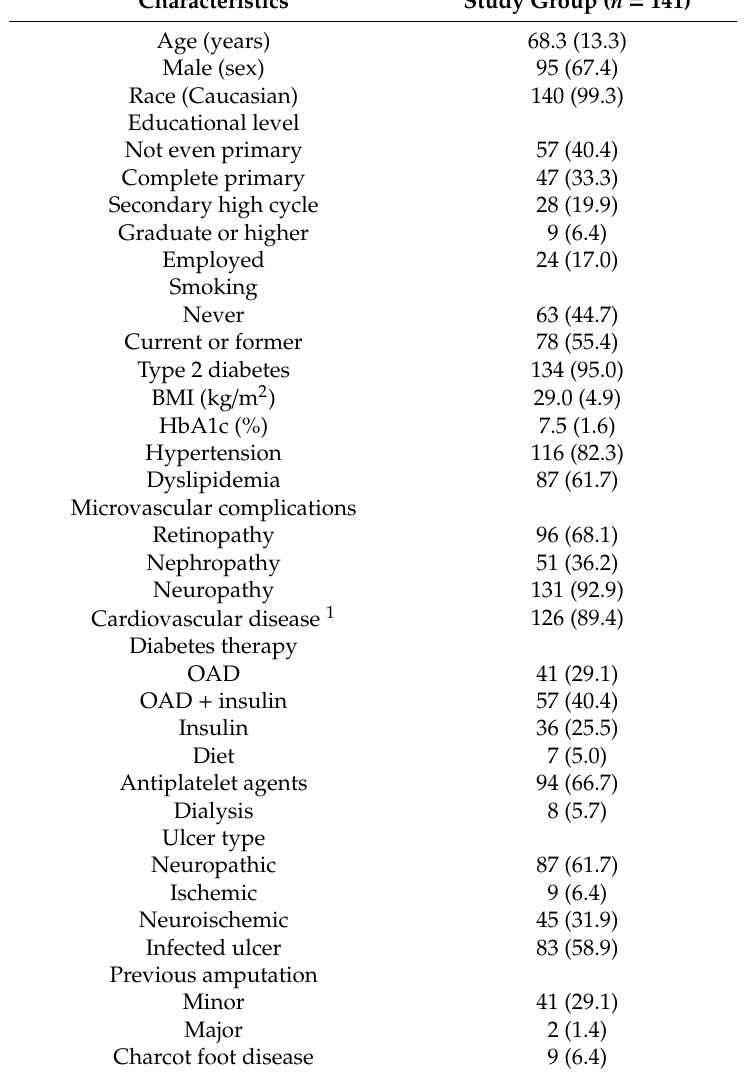
Table 1. Clinical and sociodemographic characteristics of the study group at